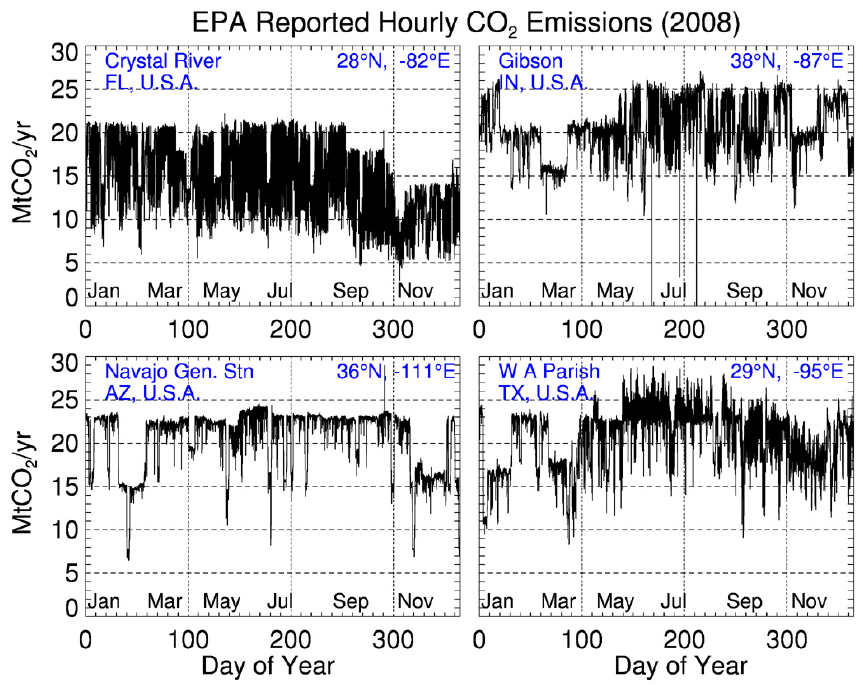
Fig. 1. Hourly CO 2 emissions from four selected power plants in the US as reported to the EPA. For consistency, the hourly CO 2 emissions (in tons CO 2 h − 1 ) were converted to MtCO 2 yr − 1 .